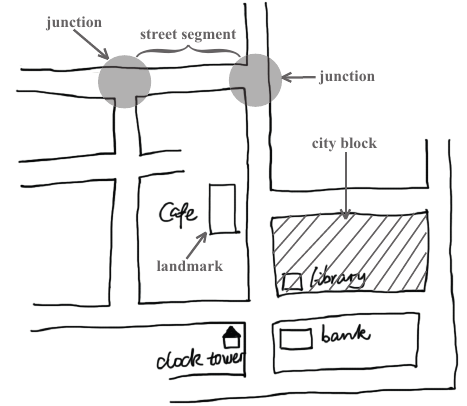
Figure 1: Sample spatial objects defined in a sketch